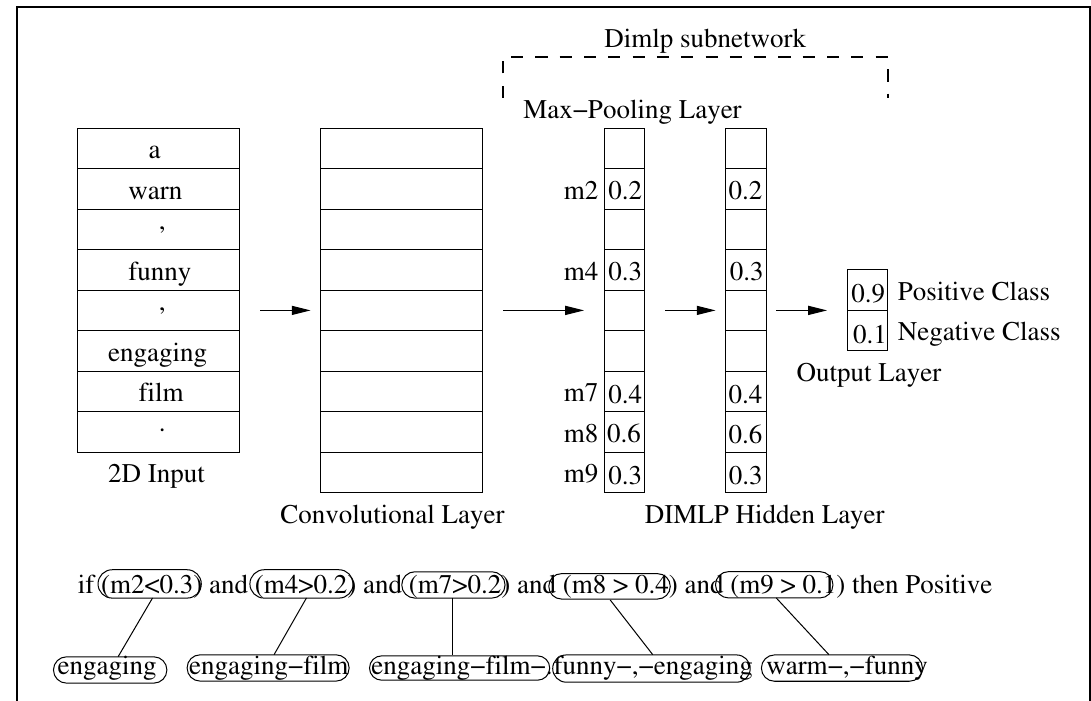
Figure 6. Flow of data in the interpretable CNN (see the text for more